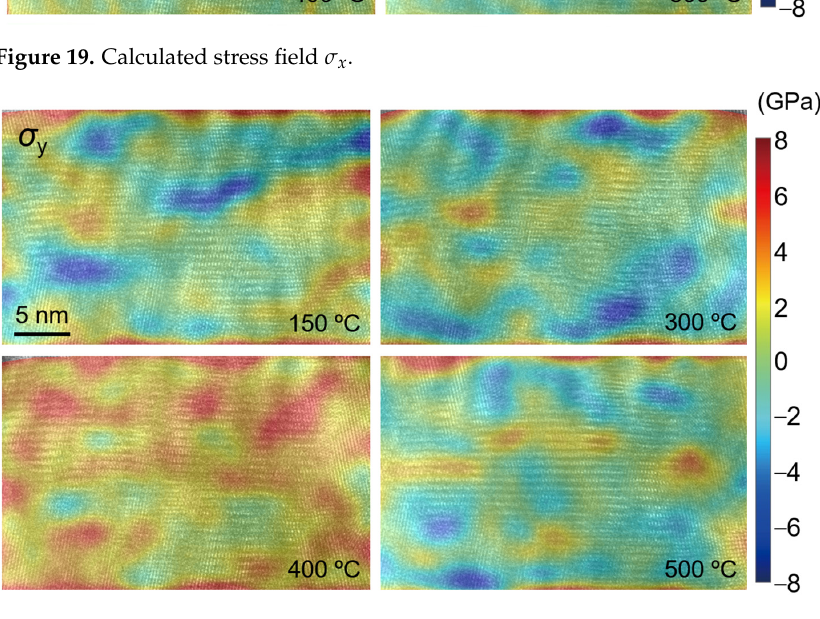
Figure 20. Calculated stress field σ y .